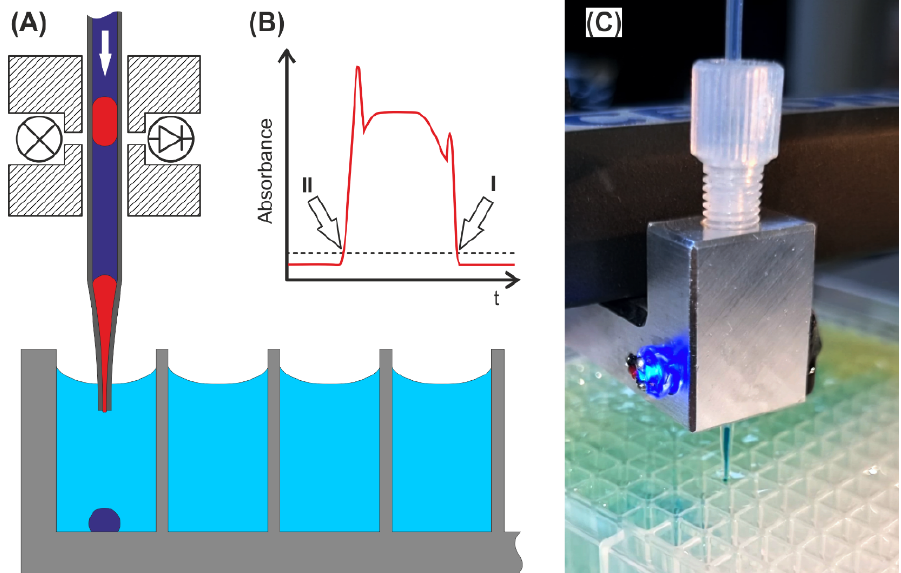
Figure 9. Droplet to vial transfer: ( A ) Schematic droplet dispensing into MTP wells. The tube and photoelectric sensor were mounted in a frame. The tubing was stretched to form a tip. ( B ) Signal of the photoelectric sensor (LED 470 nm, Photodiode) during droplet passage. If the absorbance signal exceeds the set threshold, the droplet front (I) and end (II) can be detected and used as trigger signal for the robotic movement. ( C ) Image of the transfer tool dispensing droplets into a prefilled 384-well plate. (See Video_S6).